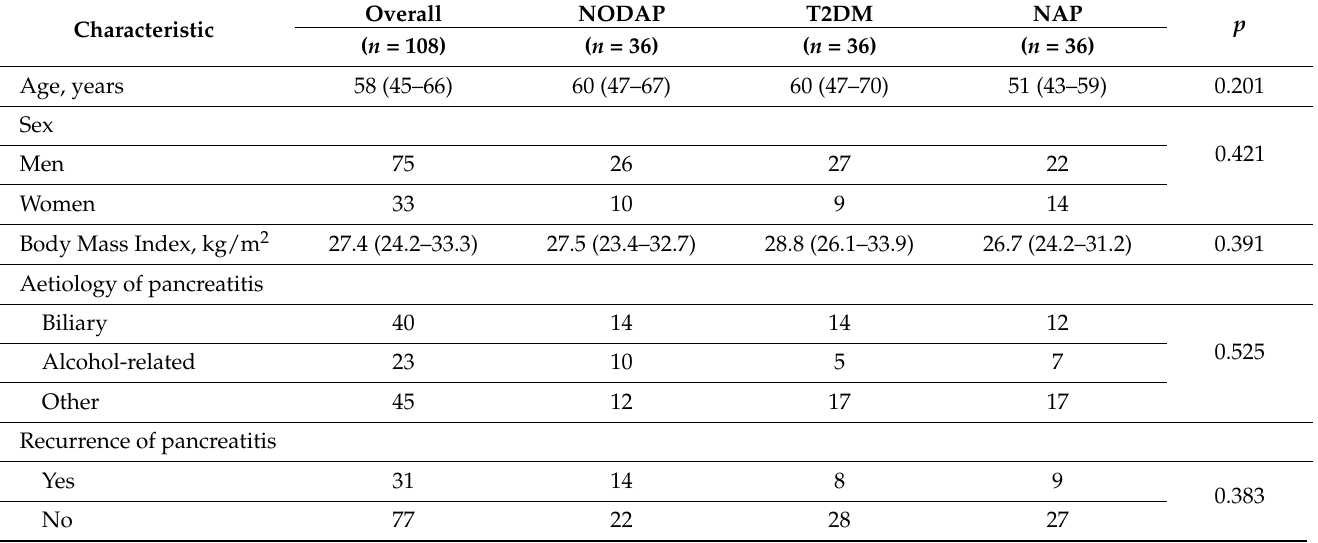
Table 1. Characteristics of the study